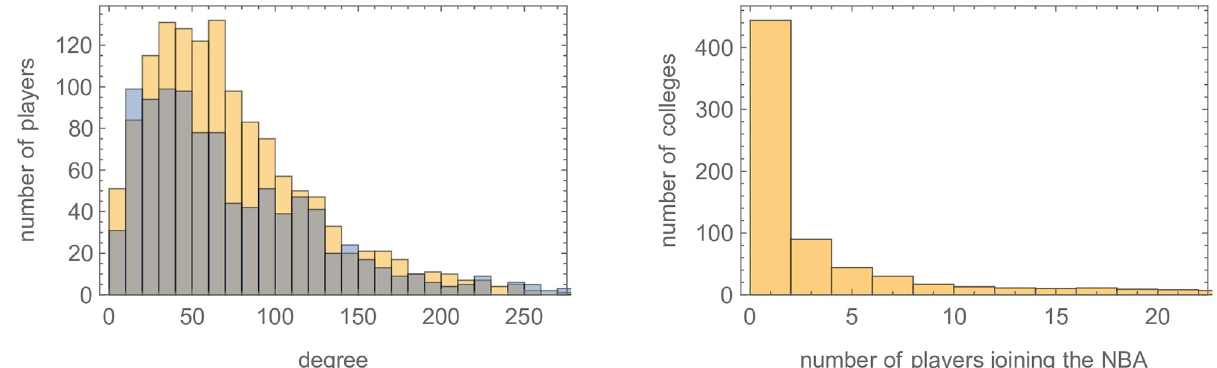
Fig 2. Left: A histogram of the degree (centrality) for the baseball Twitter network and the basketball Twitter network shown in orange and grey, respectively. Right: A histogram of the number of colleges that had one of more basketball players join the NBA from 2001–2019.